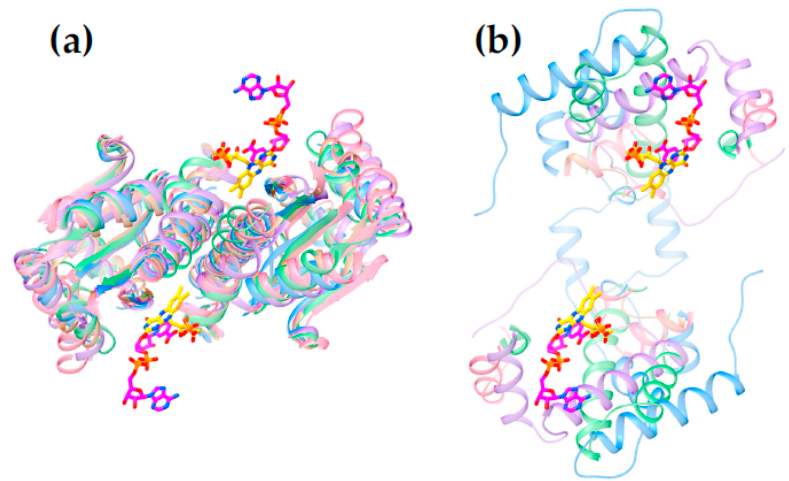
Figure 4. S uperposition of NR-related superfamily members. ( a ) Common core structure is evident in an overlay of representatives of each of the NfsB (green), NfsA (blue), PnbA (purple) Frm2 (pink) and HUB (rust) subgroups. Panel ( c ) extracts the core secondary structure shared by the different subgroups (same overlay), while ( b ) shows all backbone ribbon present in ( a ) but excluded from ( c ). Structures used are 1F5V (NfsA), 5J8D (NfsB), 2WZW (PnbA), 2IFA (Frm2) and 3E39 (HUB). All molecular graphics were produced using Chimera [79].